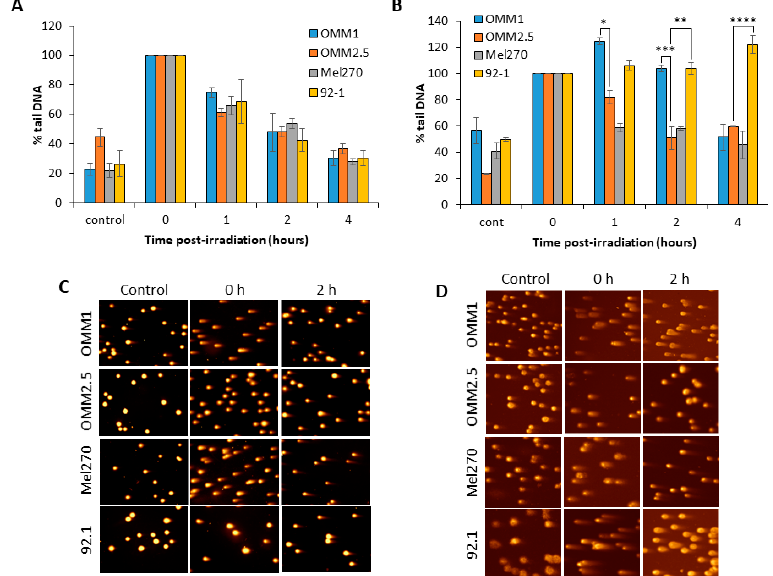
Figure 2. Repair of DSBs in UM cells in response to X-ray and proton irradiation. Cells were irradiated with ( A ) X-rays or ( B ) protons at 4 Gy, and DNA DSBs were measured at various time-points